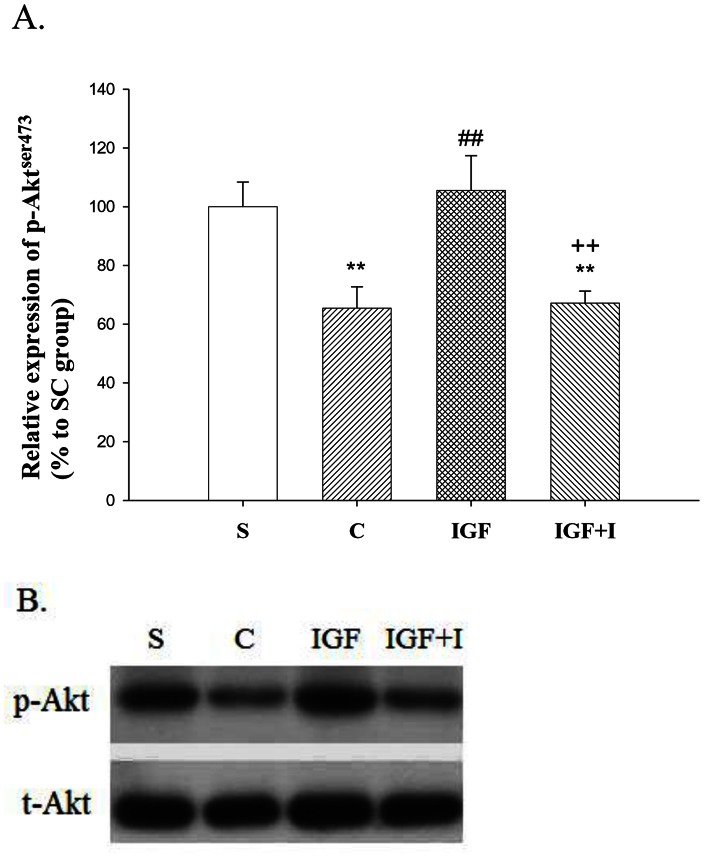
The relative expression of p-Akt in the right motor cortex (n = 8 for each group).
A: The quantification of the relative expression of p-Akt. All of the data are represented as the ratio of p-Akt band density to t-Akt band density and presented as a percentage to the p-Akt to t-Akt ratio of the S group. B: Western blot results. **, P<0.01 vs. S group; ##, P<0.01 vs. C group; ++, P<0.01 vs. IGF group. S: Sham control; C: MCAO control; IGF: MCAO with IGF-I treatment; IGF+I: MCAO with AG1024 and IGF-I treatment.